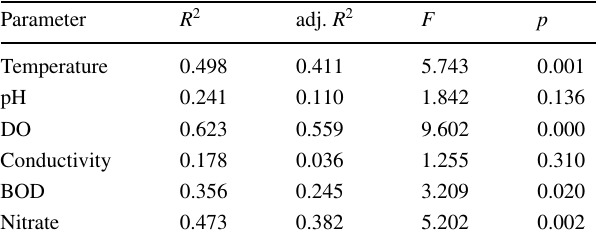
Table 4 One-way ANOVA for rainy season